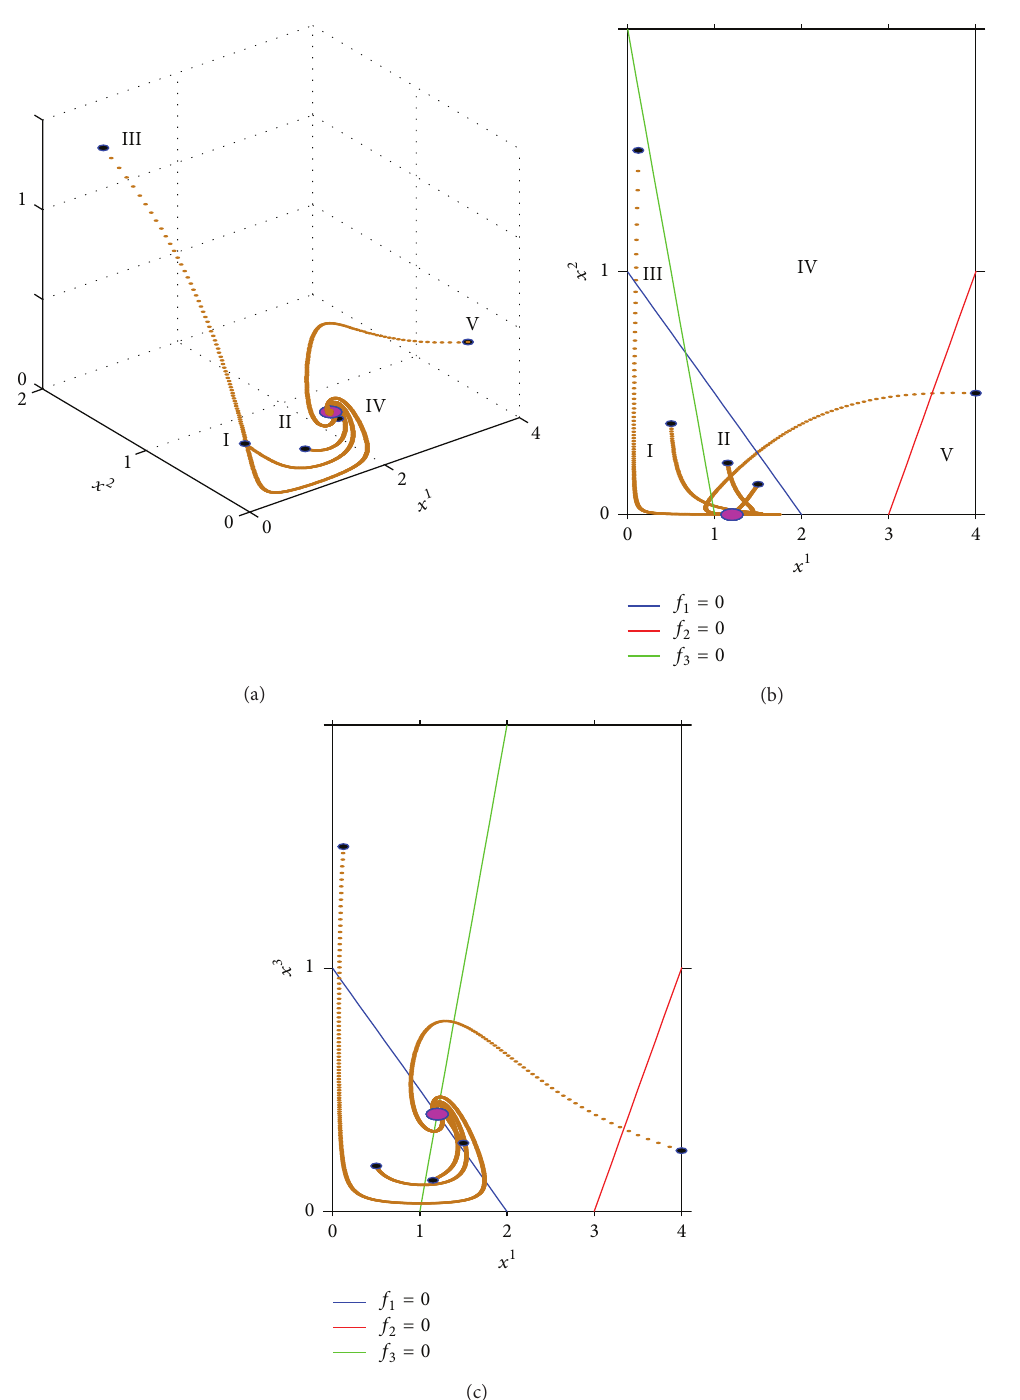
Figure 2: Trajectories for five different initial points denoted by the black circles. The initial points are (0.5, 0.375, 0.3562), (1.15, 0.2125, 0.1281), (0.125, 1.5, 1.5), (1.5, 0.125, 0.2813), and (4, 0.5, 0.25), which are contained in regions I, II, III, IV, and V defined in (11), respectively. The brown dotted lines mean the trajectories which converge to 𝜗 = ( 6 / 5 , 0 , 2 / 5 ) , denoted by the magenta circle. The three planes 𝑓 𝑖 = 0 are depicted in Figure